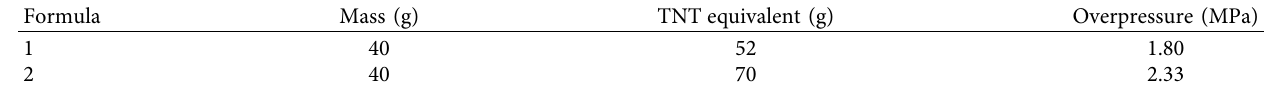
Table 2: Peak pressure of the first incident shock